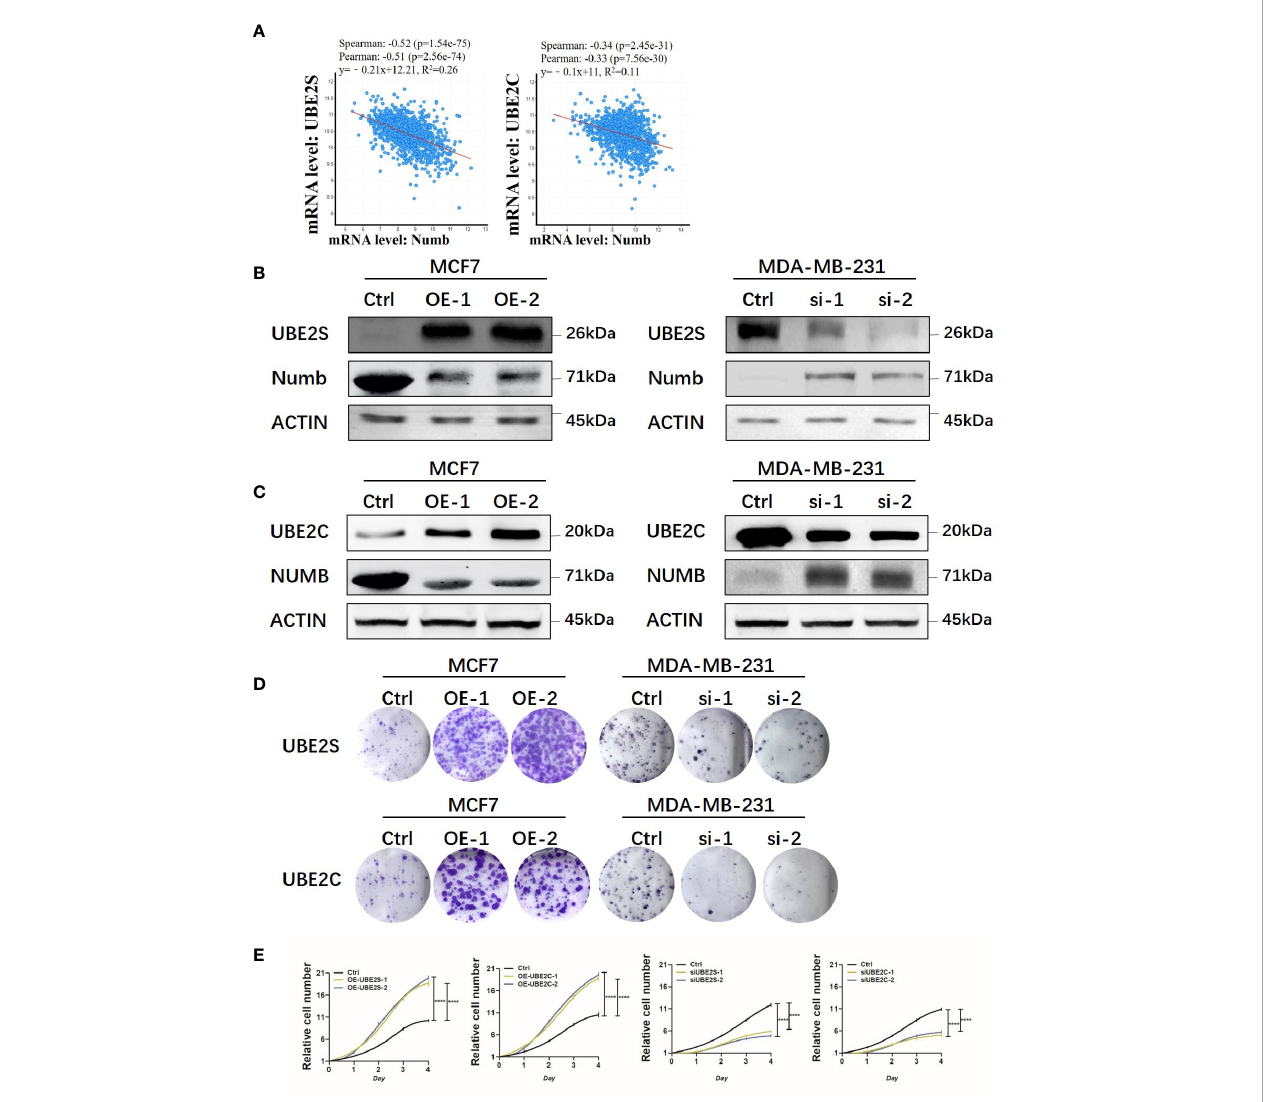
FIGURE 9 UBE2S and UBE2C inhibit Numb expression and increase colony formation and cell growth. (A) Numb has a negative correlation with UBE2S and UBE2C at the mRNA level in breast cancer tissues by cBioPortal database analysis. TCGA, Firehose Legacy, 1,101patients/1,108 samples. The Pearson ’ s correlation score, Spearman score, and p -value were indicated in the respective graphs. UBE2S (B) and UBE2C (C) are overexpressed (OE) in MCF7 cells and knocked down with small interfering RNA (si) in MDA-MB-231 cells, and the Numb protein level is determined through western blot. b -actin was used as a loading control. Colony formation (D) and the CCK-8 growth assay (E) are performed in these cells. Each assay was repeated at least three